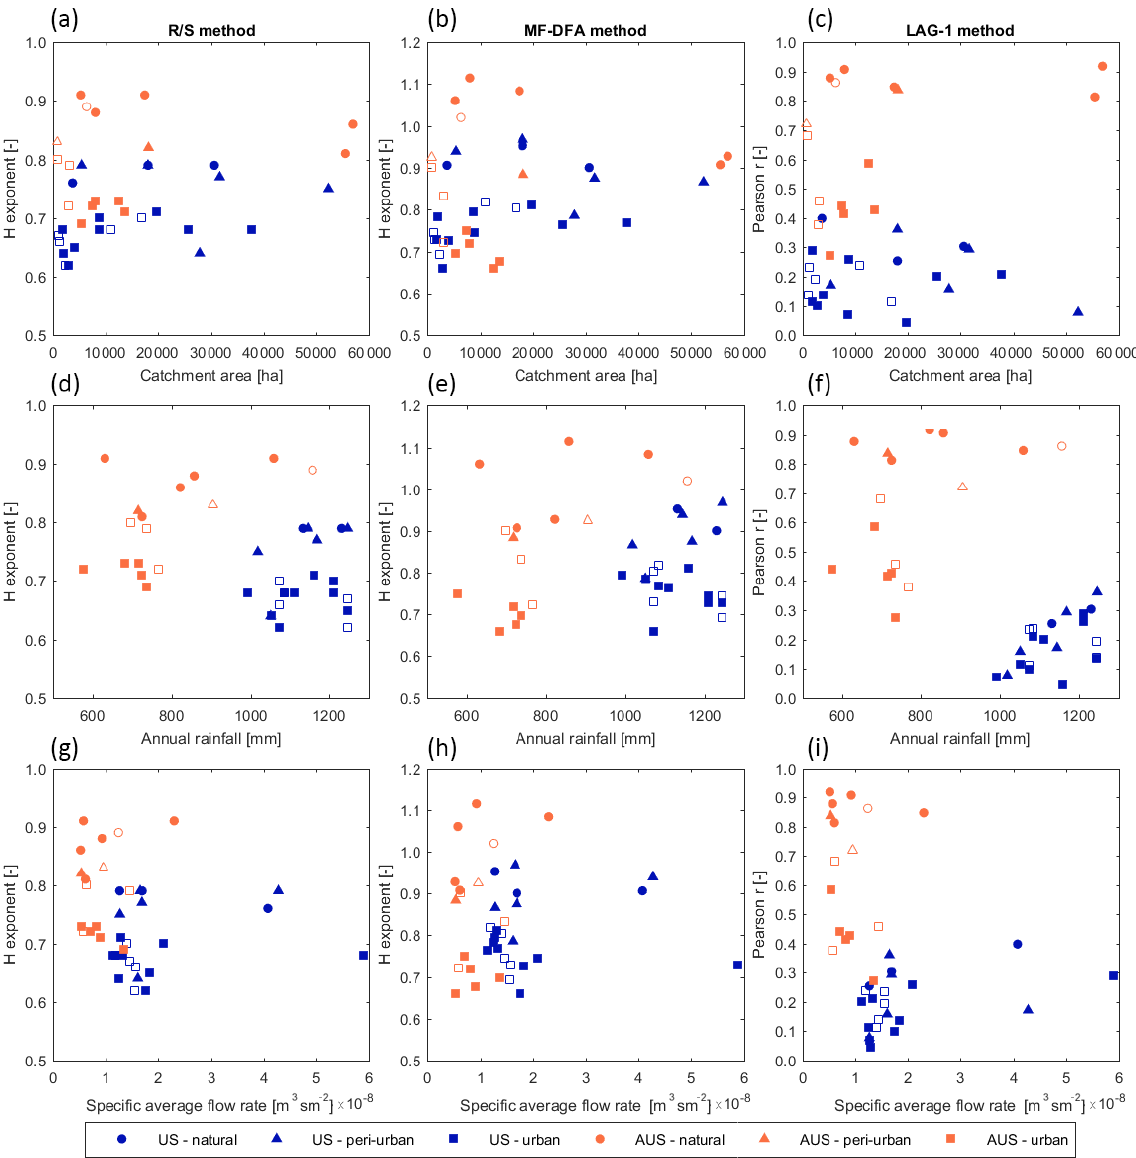
Figure 3. Relationship between the H exponent of the streamflow series (estimated with the R/S method a, d, g and with the MF-DFA method b, e, h ), and lag-1 Pearson autocorrelation coefficient (c, f, i) with the catchment size (a, b, c) , annual rainfall (d, e, f) and average flow rate per unit area (g, h, i) for catchments in the USA and Australia. Time series with gaps longer than 200 consecutive days have empty